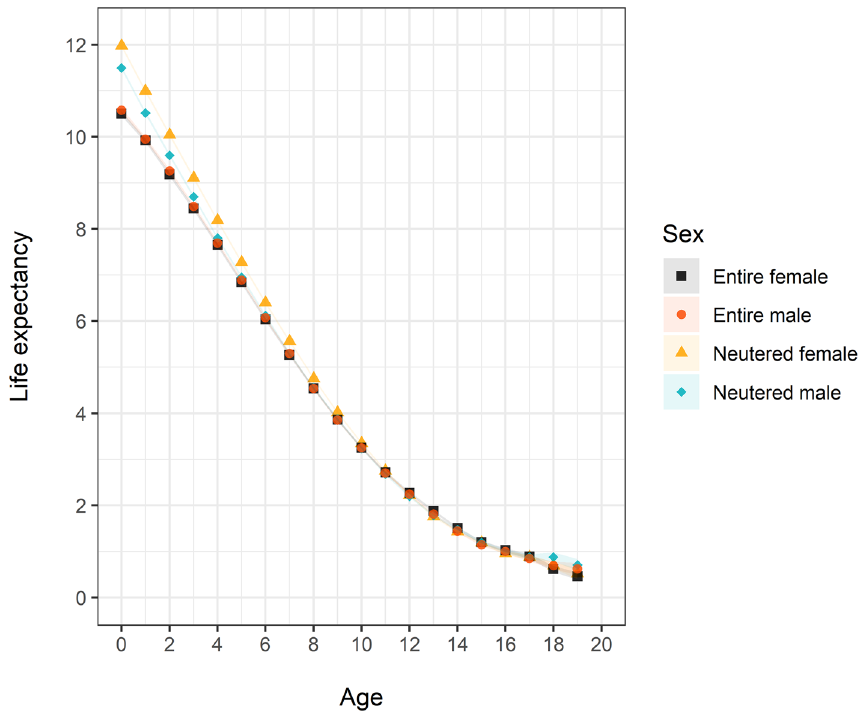
Figure 1. Life expectancy and the 95% confidence interval for female and male dogs at different ages (year) under primary veterinary care in the UK.